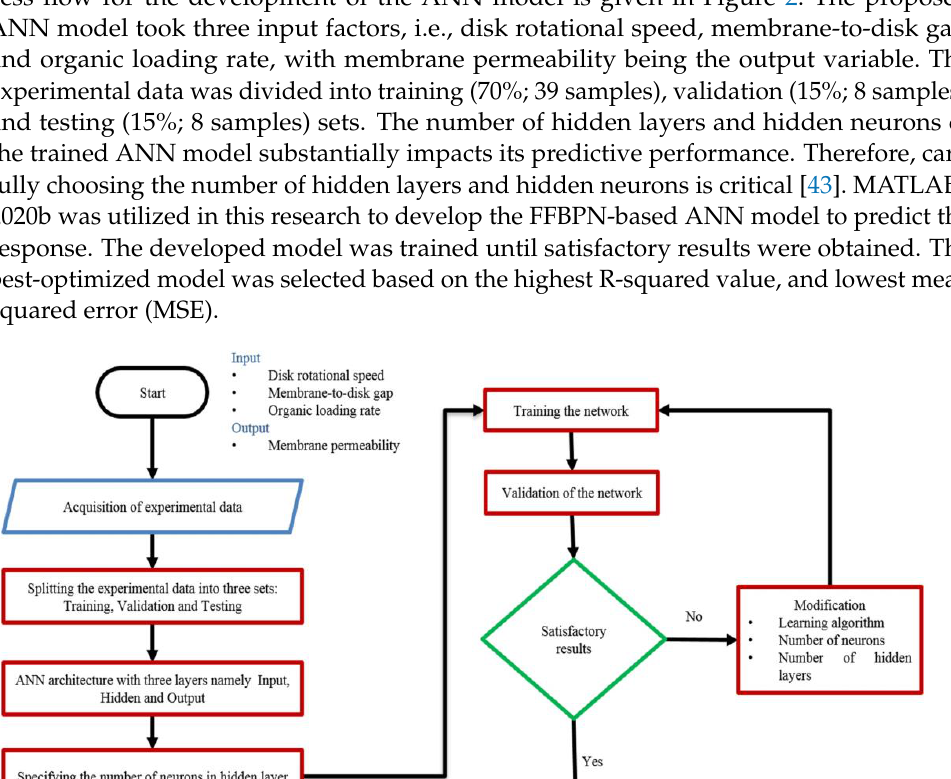
Table 3. Design of experimental runs for the independent variables and response functions.